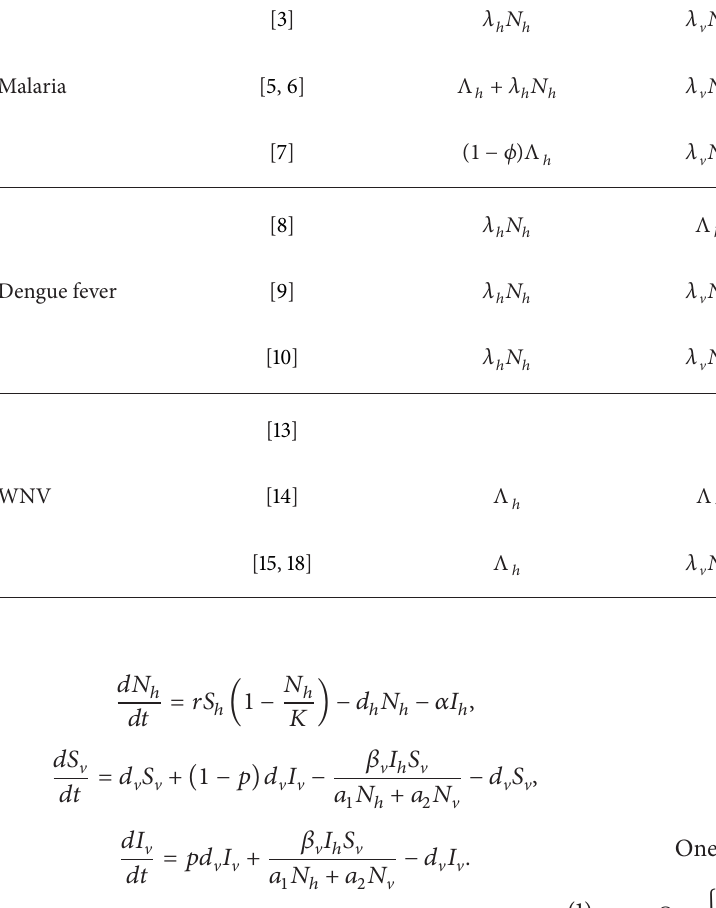
Table 1: The birth and incidence rates for different vector-borne disease models.